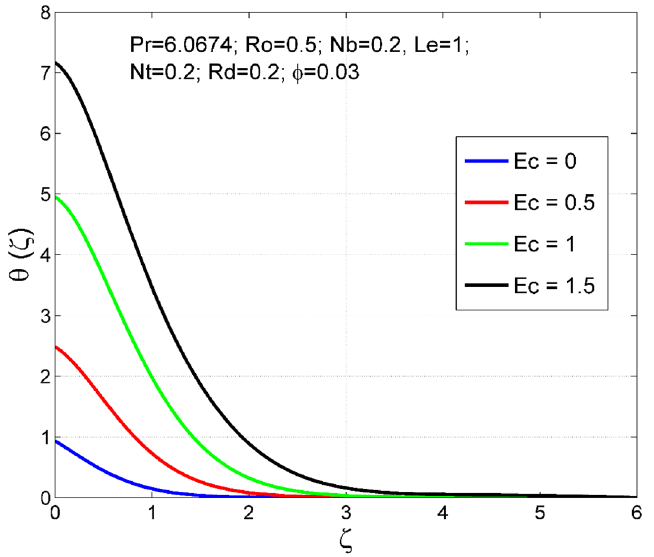
Figure 10. Effect of Ec on θ (ζ)